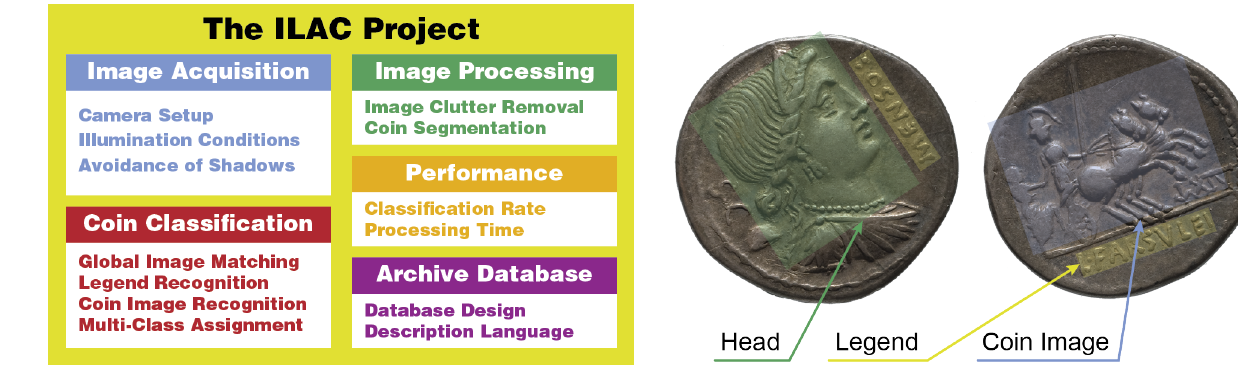
Figure 3: Obverse and reverse of a Roman Republican coin with its individual parts highlighted. This example’s obverse shows the crowned head of the godess Liberta while its reverse depicts a quadriga as main coin